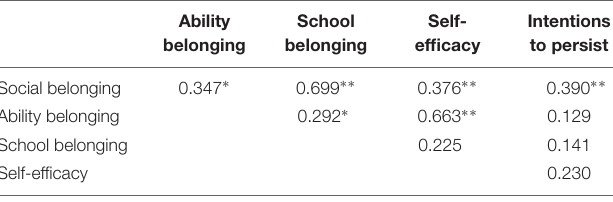
Ability School Self- Intentions belonging belonging efficacy to persist